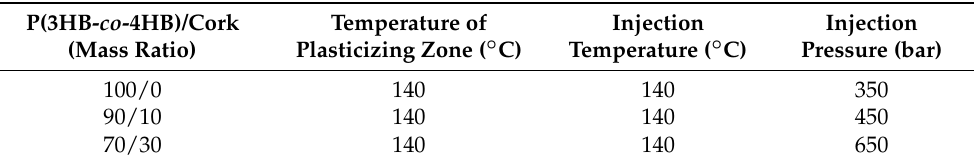
Table 1. Processing parameters for sample